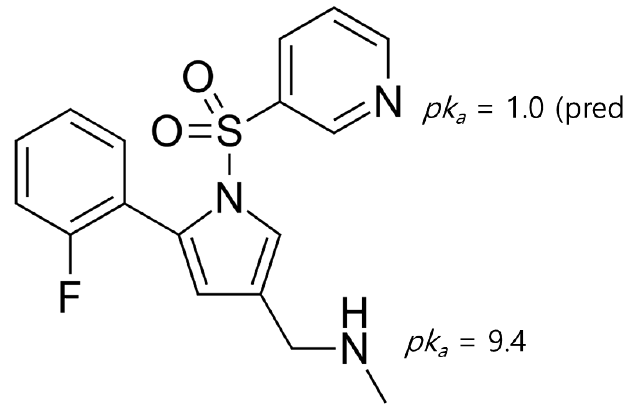
Figure 1. Chemical structure of vonoprazan (VPZ) and pK a